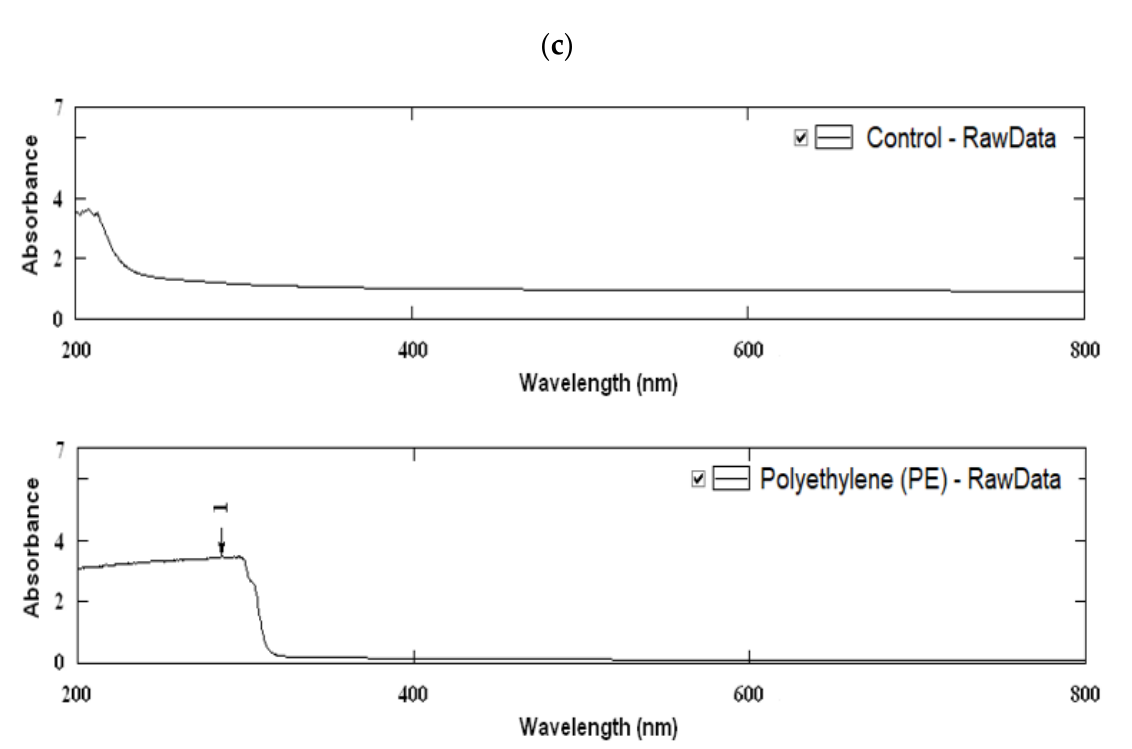
Figure 3. Stacked absorption spectra between 200 and 800 nm of the membranes with AA ( a ), calcium chloride ( b ), control sample and PE membrane ( c ).